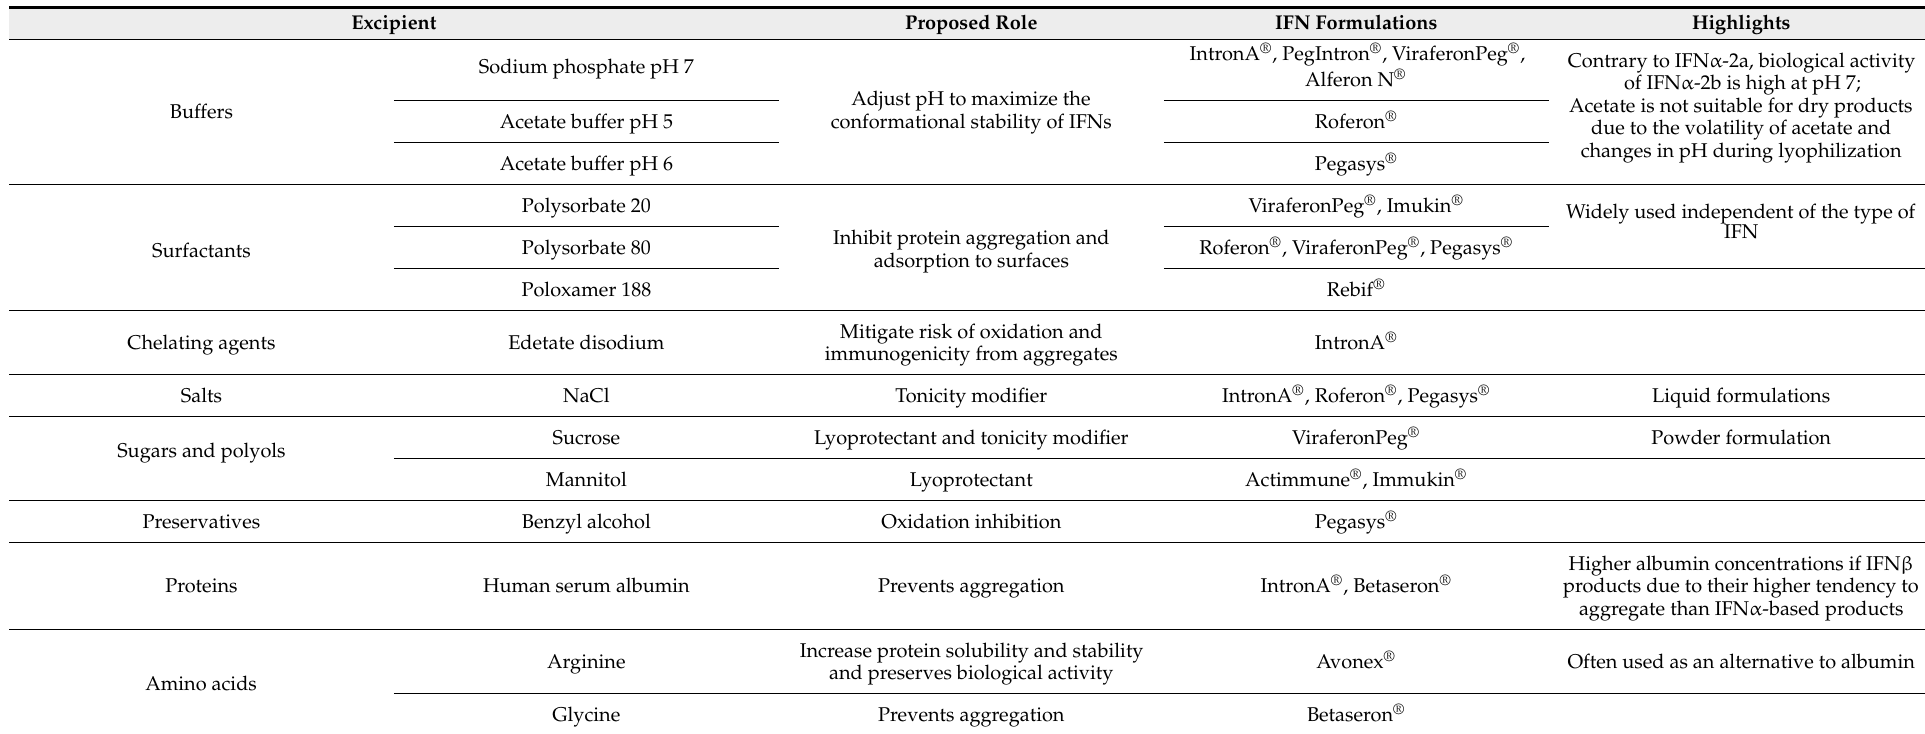
Table 6. Overview of formulation excipients commonly used in IFN products